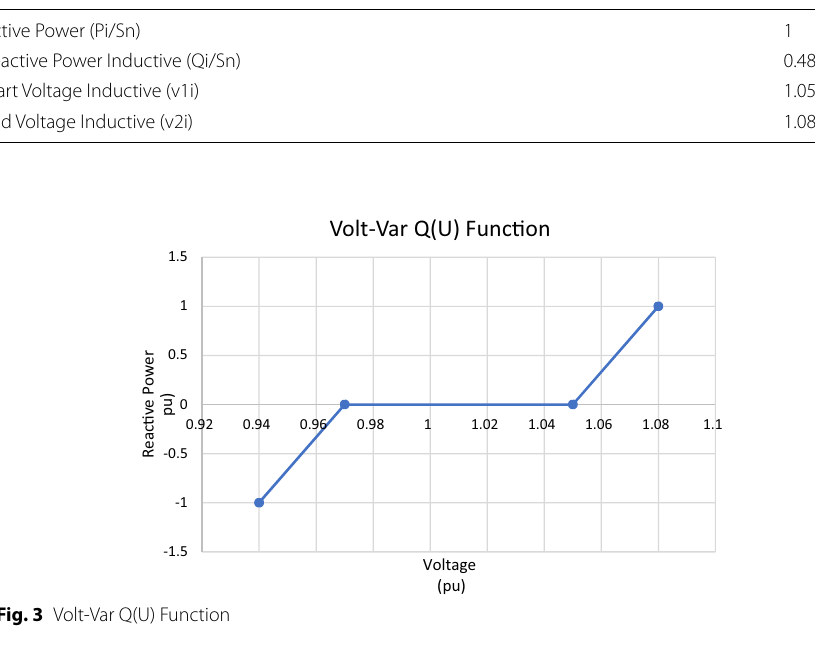
Table 2 Controller settings of smart inverter with volt-var function Parameters Value (p.u.)